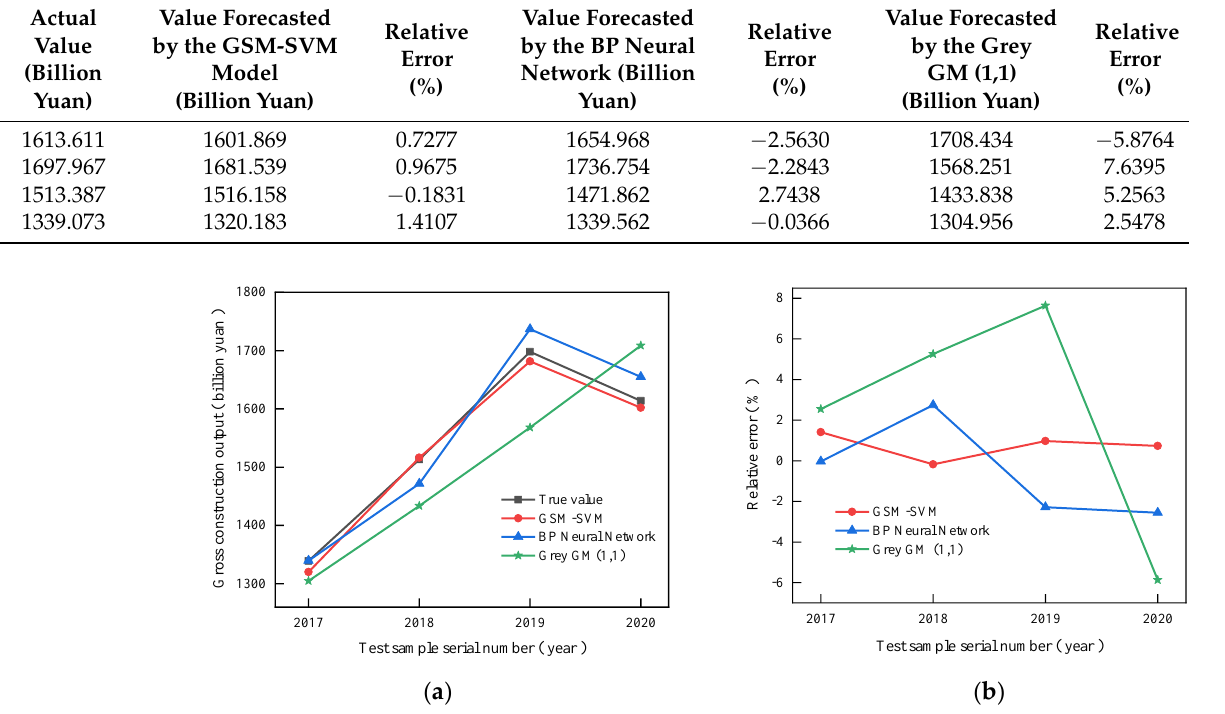
Table 4. Comparison between the gross output forecasted by the three models and the actual value of the construction industry.